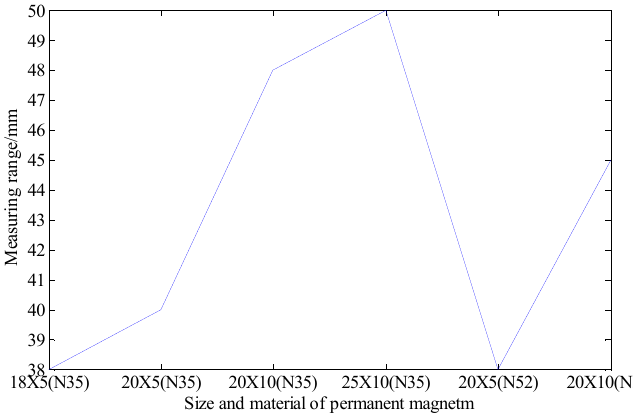
Figure 4. Updating structure design of sensing unit based on 3D printing. ( a ) 3D simulation model of sensing unit structure based on 3D CAD/CAM software and physical figure of each component; ( b ) photograph of device structure.